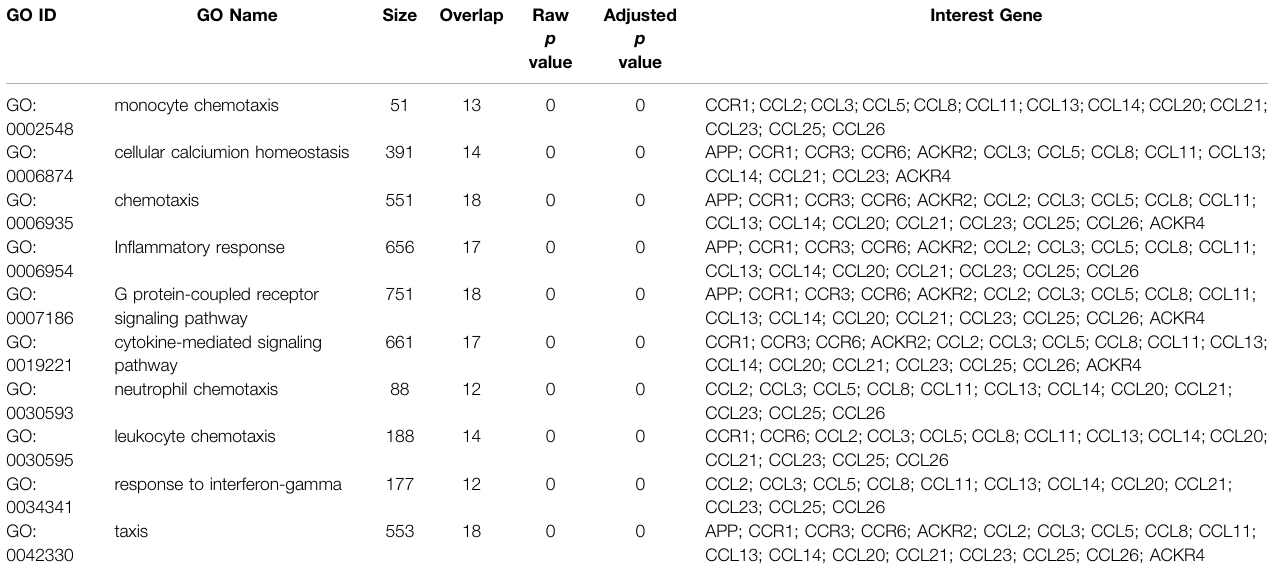
TABLE 2 | The GO functional enrichment of chemokines CCL and their neighboring genes